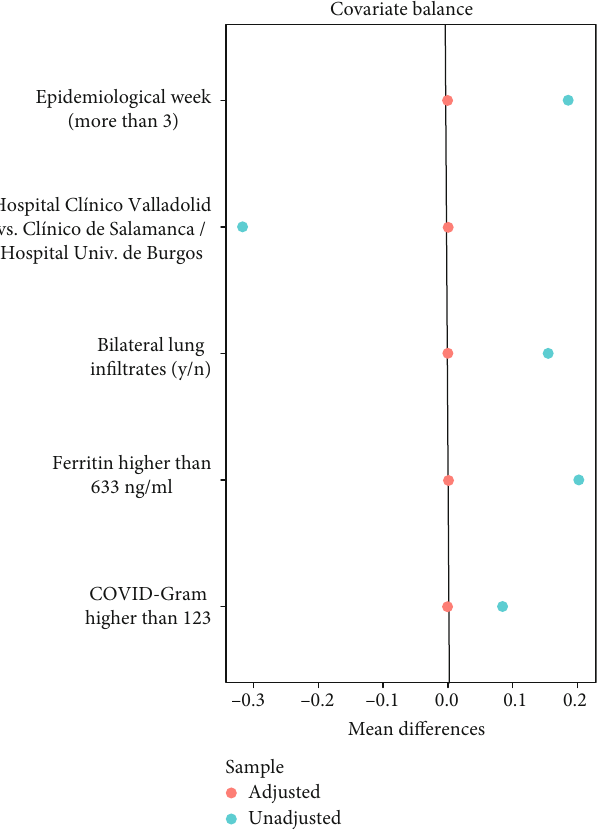
Figure 2: Love plot of the propensity score matching using the exact